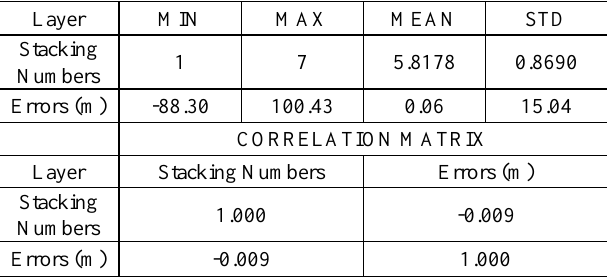
Figure 12. The stacking map of the ASTER GDEM2 data Table 3 shows the statistics of the errors of ASTER GDEM and the stacking numbers. The maximum and the minimum stacking number are 7 and 1 respectively. The mean and the standard deviation of the stacking numbers are 5.8178 and 0.8690. The correlation coefficient between the errors of ASTER DEM and the stacking numbers is -0.009, which indicates that the accuracy of ASTER GDEM2 is negatively correlated to the number of stereo observations. The errors tend to be large in the areas that less observed and small otherwise. Table 3. Statistics of the stacking numbers and the errors